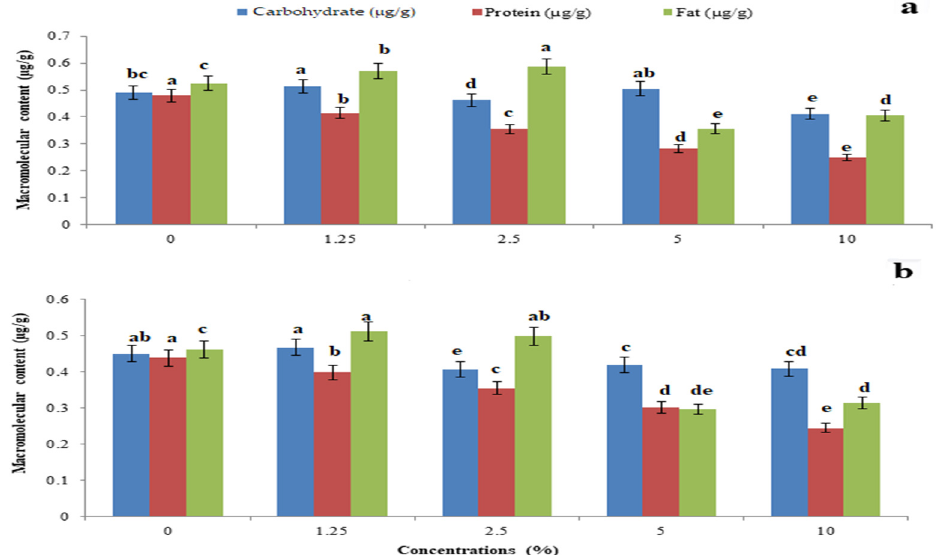
Figure 6. Whole-body carbohydrate, protein, and fat ( µ g/g) of P. solenopsis exposed to different concentrations of I. carnea ( a ) and I. carnea- AgNPs ( b ). Different letters (among the same concentration for each enzyme separately) above bars indicate significantly different means according to Tukey’s test ( p < 0.05). Bars indicate the standard error (SE).